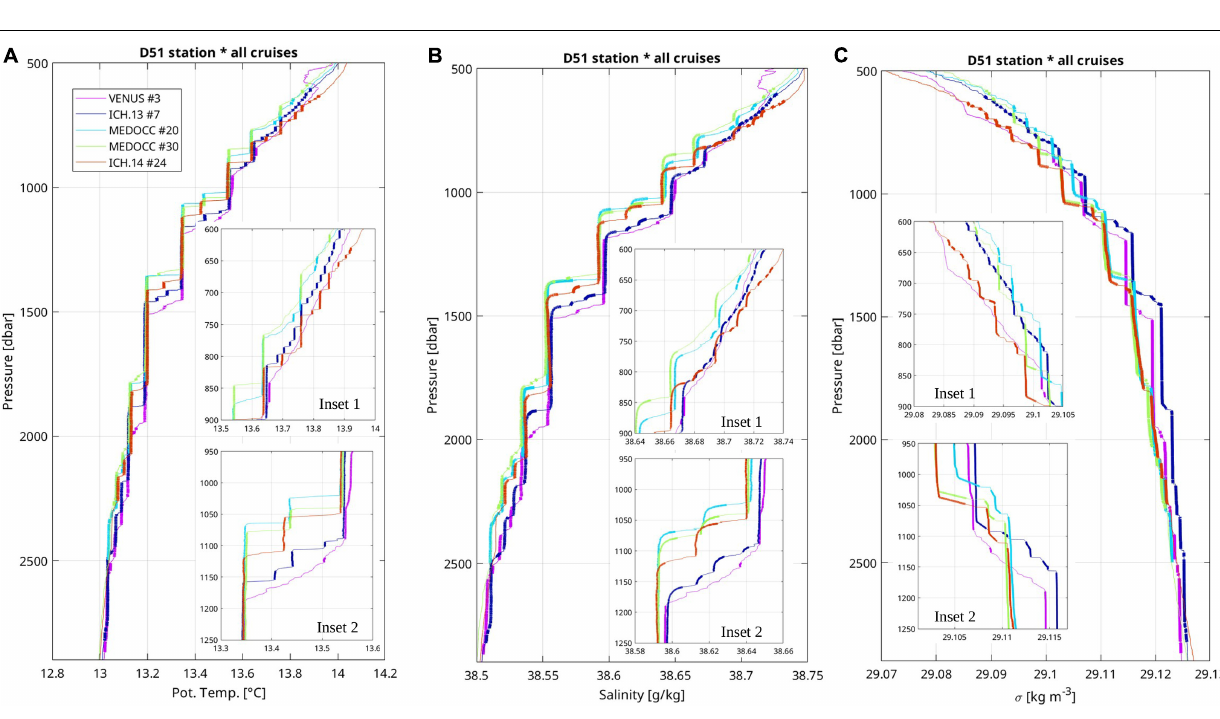
Frontiers in Marine Science |